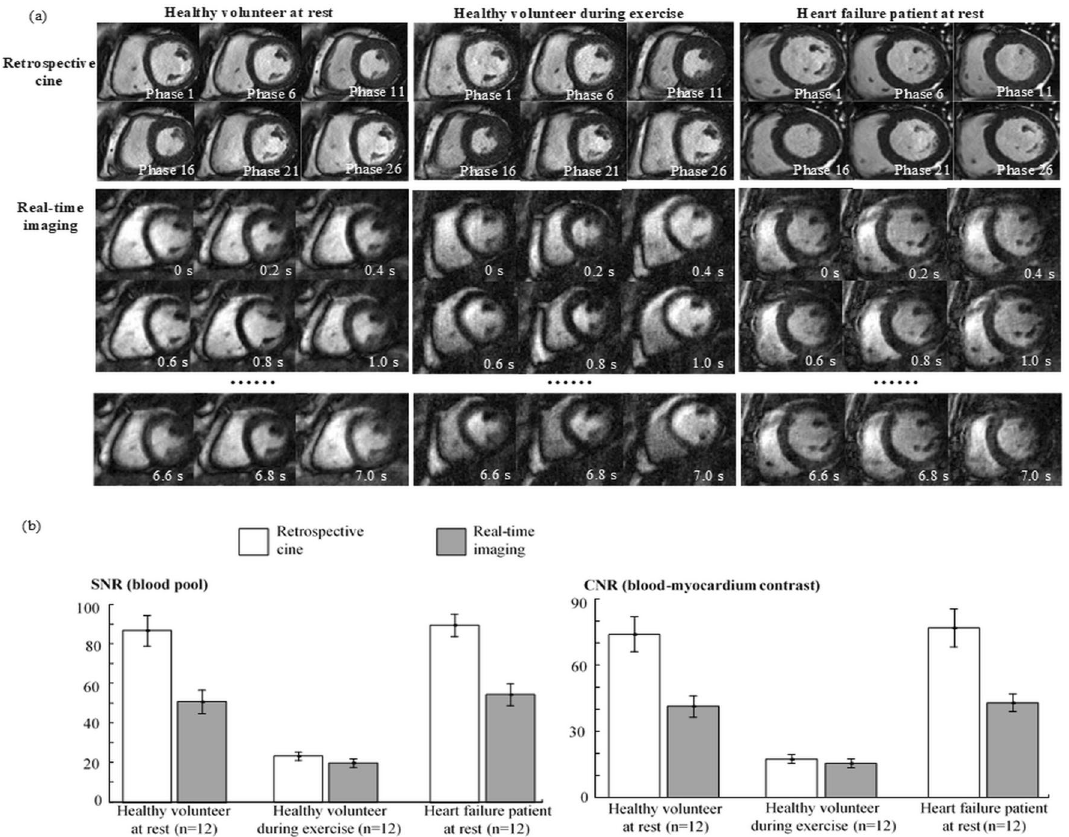
Figure 1. ( a ) Selected time frames of the image examples from retrospective cine and real-time imaging in a resting-state healthy volunteer, an exercising-state volunteer, and a heart failure patient. ( b ) Bar plots of SNR and CNR measurements in retrospective cine and real-time images from different groups of the subjects. Each bar is presented as mean ± standard deviation (n = 12). Resting-state healthy volunteers Exercising-state healthy Resting-state HF patients (n = 12) volunteers (n = 12) (n = 12) RC RT DIFF